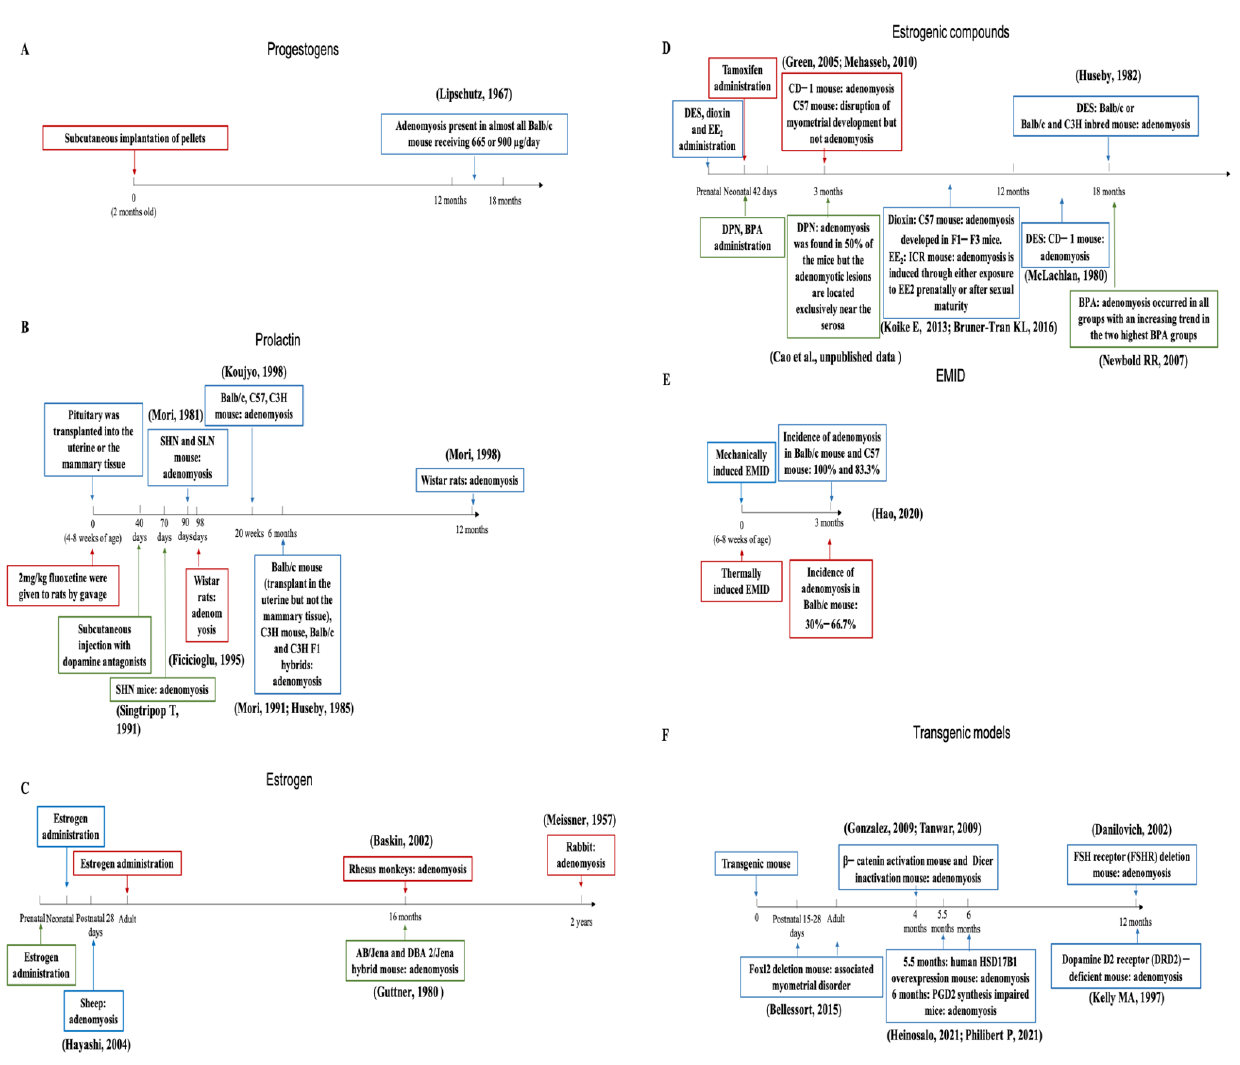
Figure 2 . Timelines of all animal adenomyosis models by species, strain, induction method, duration of induction, and results. Panels ( A – F ) represented different inducers. ( A ) Progestogens; ( B ) Prolactin; ( C ) Estrogen; ( D ) Estrogenic compounds; ( E ) EMID; and ( F ) Transgenic models. Identically colored boxes represent the same class of animal models, with the first-appeared box designating the model and the later-appeared box being the result of the former, along with the reference citation.